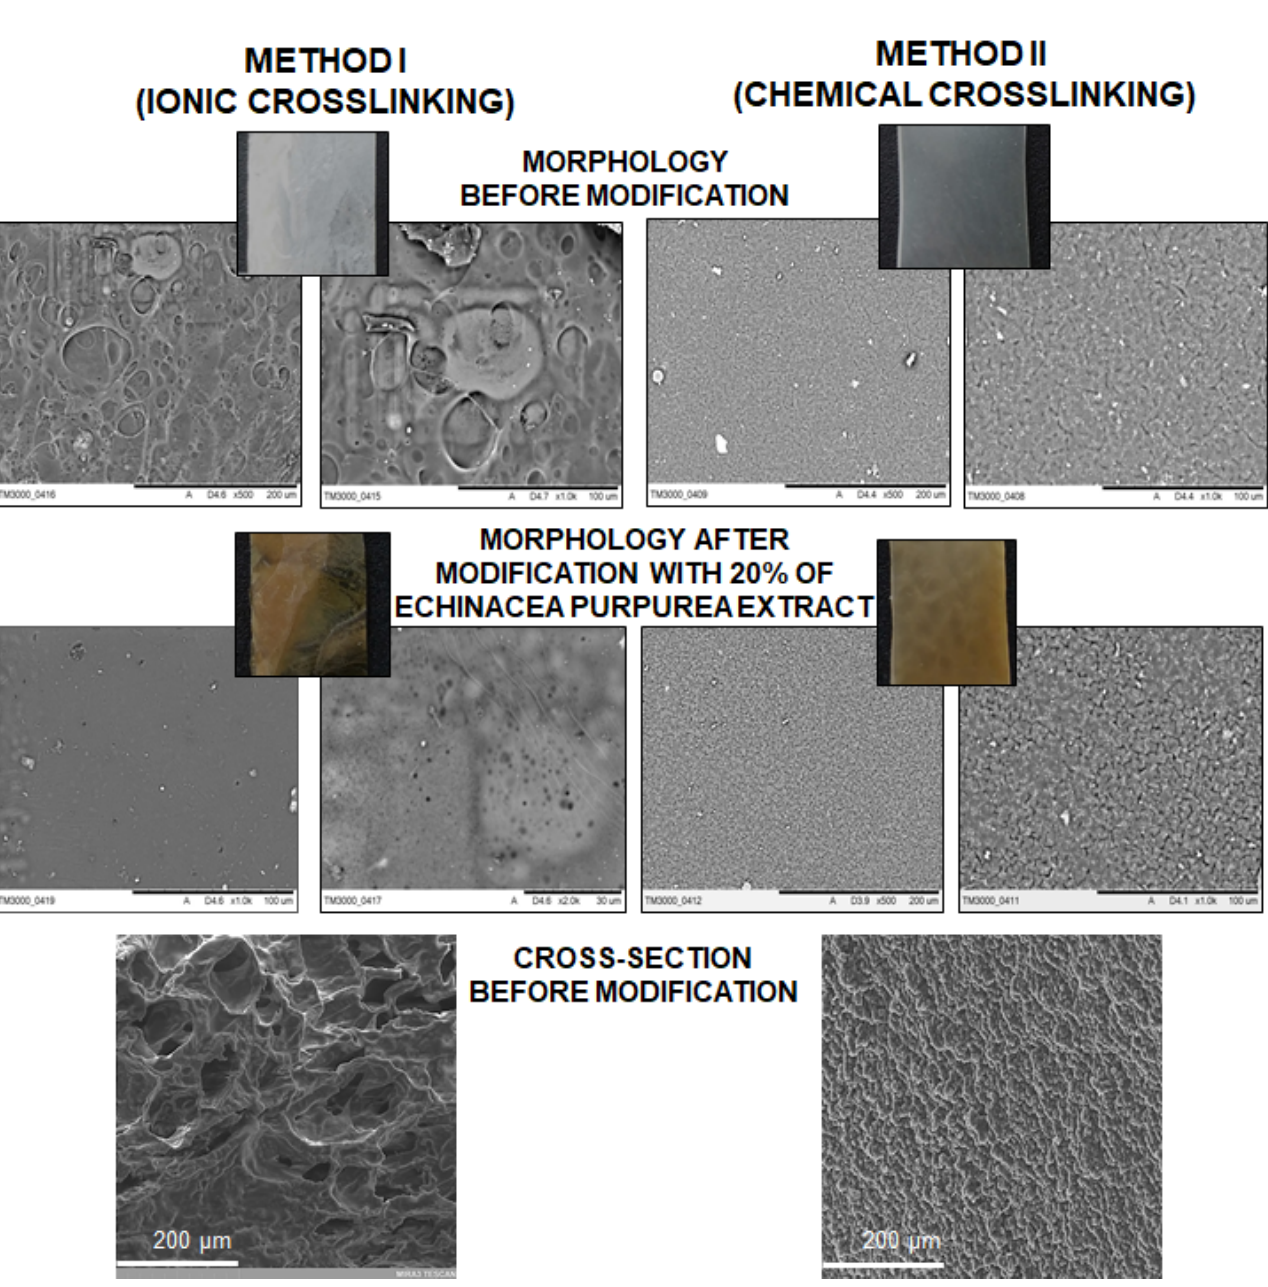
Figure 7. SEM micrographs and photographs of hydrogel materials. 2.5. The Release Profile of Echinocoside from SA/PVA/EP